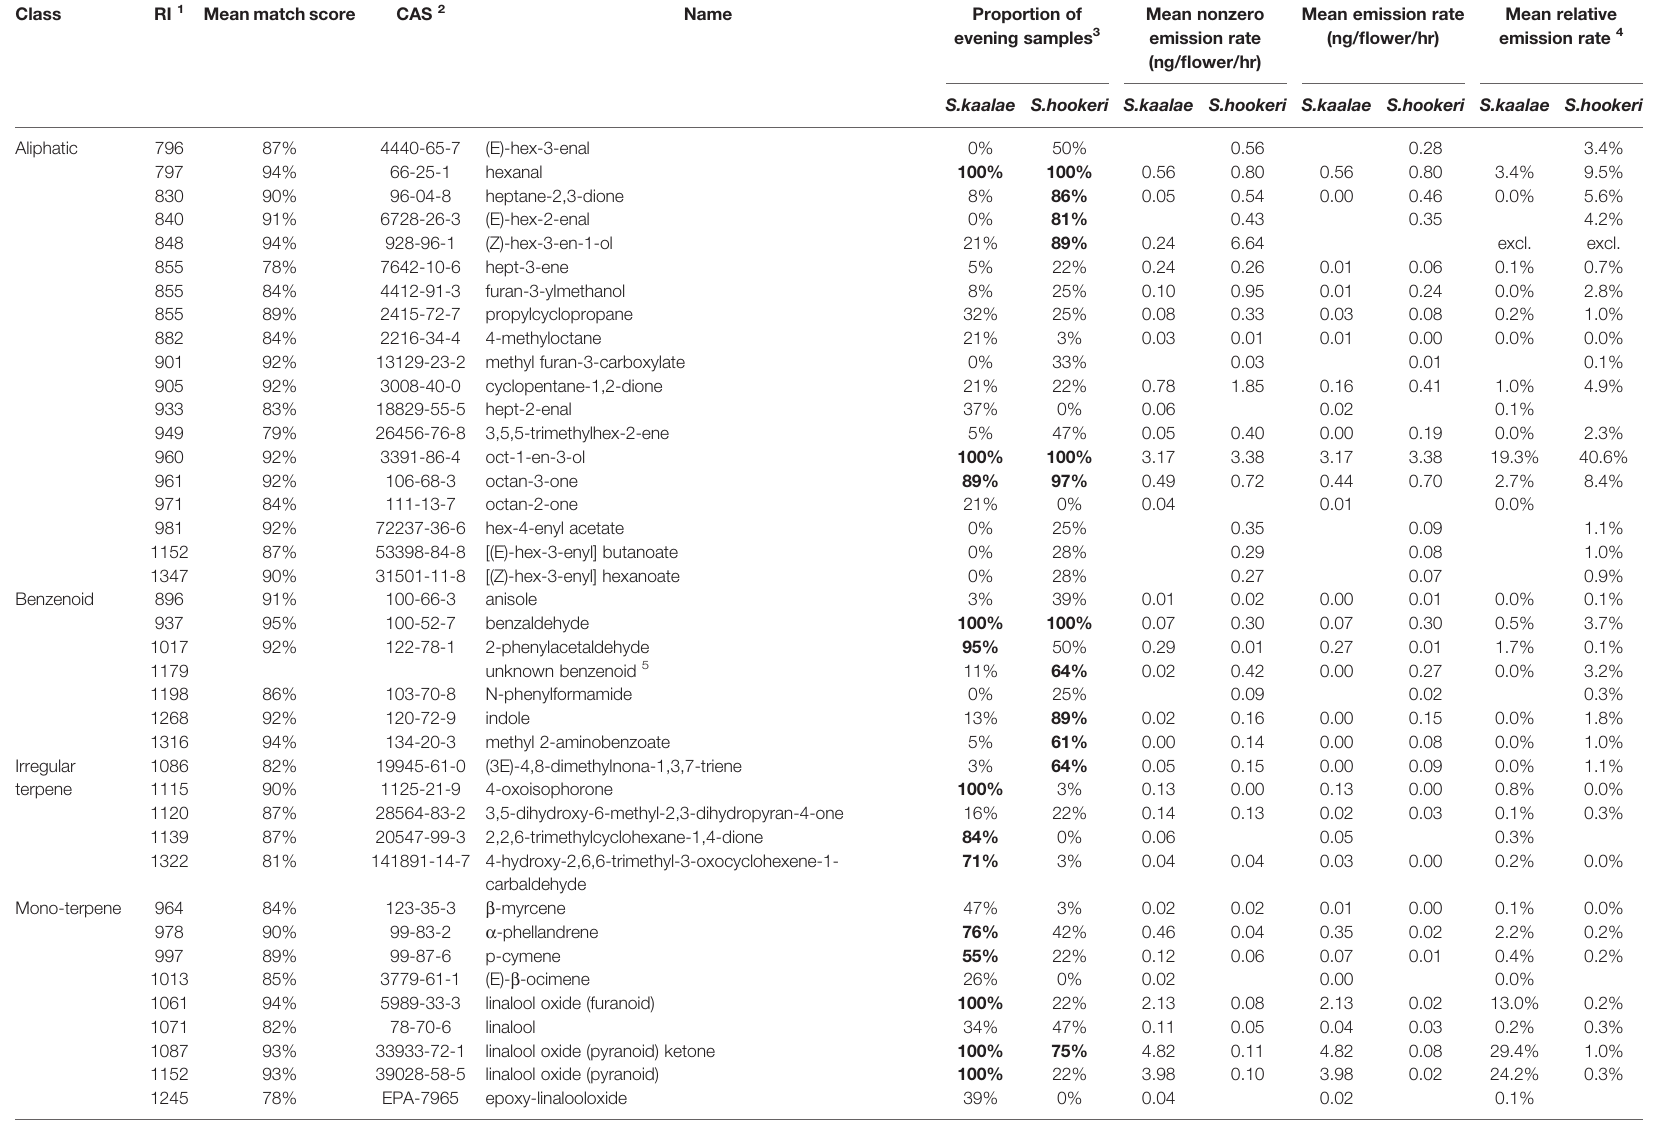
TABLE 1 | Evening fl oral volatile emissions from Schiedea kaalae and S. hookeri detected by GC-MS in > 20% of samples of either species (40 of 76 compounds, n = 32 plants for each species).